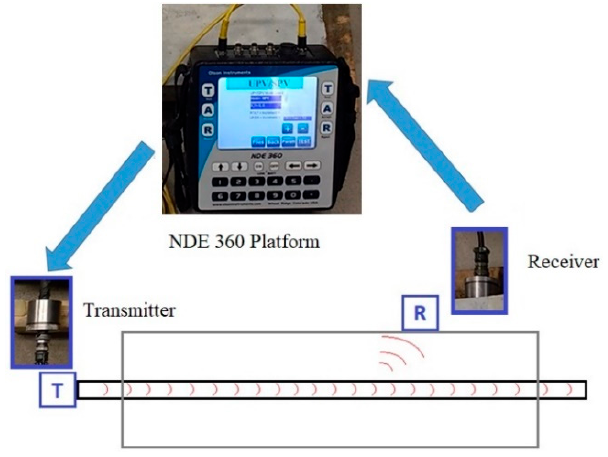
Figure 1. Ultrasonic experimental setup.